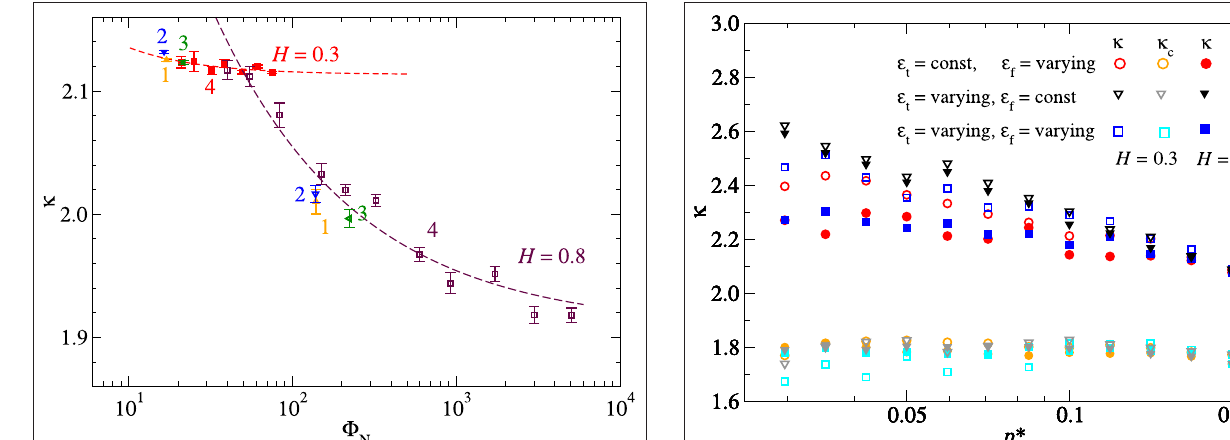
4. Symbols with faint colors represent results =